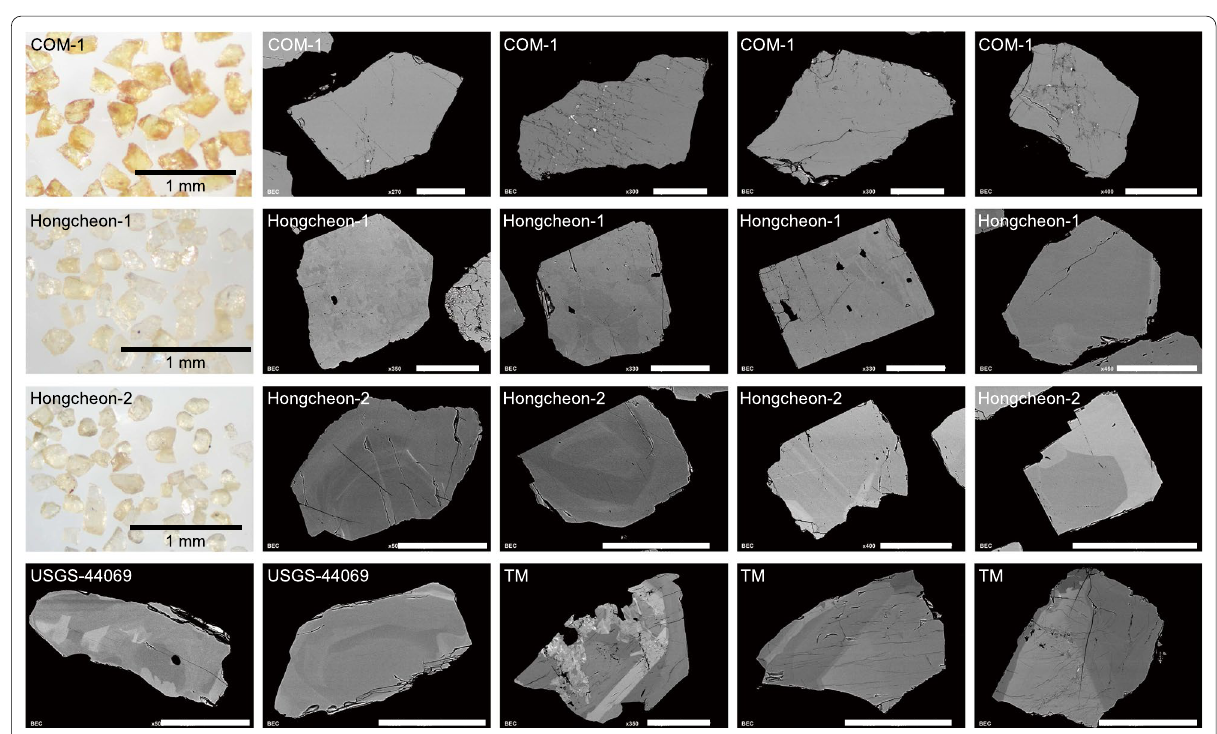
Fig. 1 Sample photographs and representative backscattered electron images of the monazite reference materials. Scale bars in backscattered electron images are 100